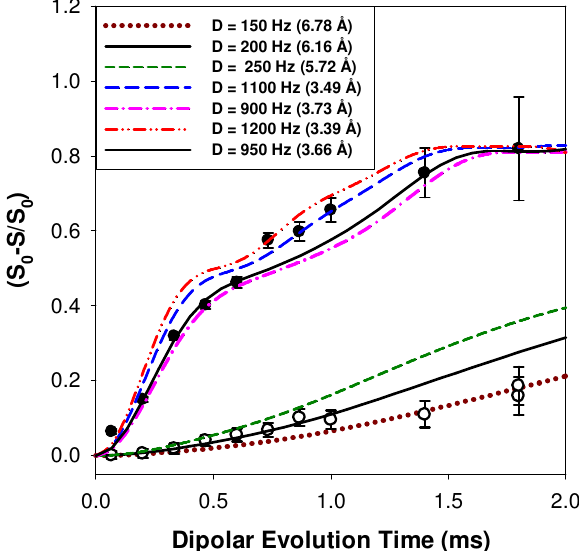
Figure 4. 1 H- 7 Li REDOR MAS NMR buildup curves for the carboxylic acid proton environments at δ = +14.7 ppm ( ● ) and δ = +13.4 ppm ( ○ ) in the p9AA-43%Li ionomer